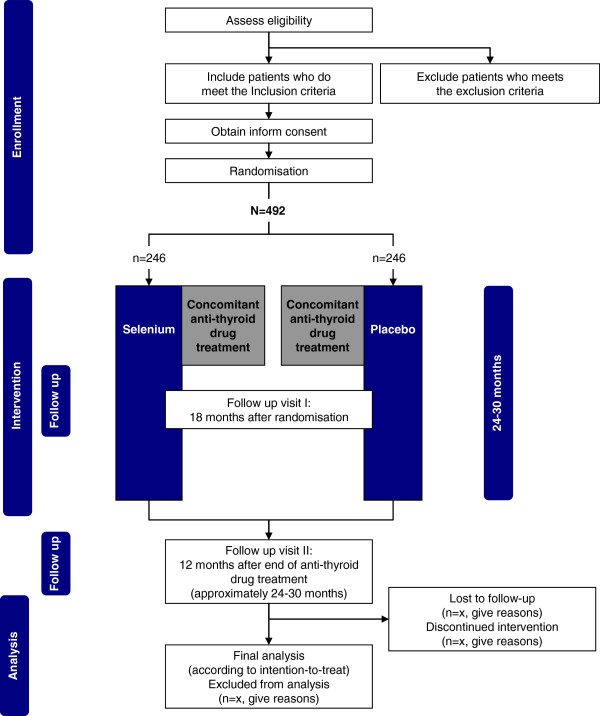
Trial flow chart.